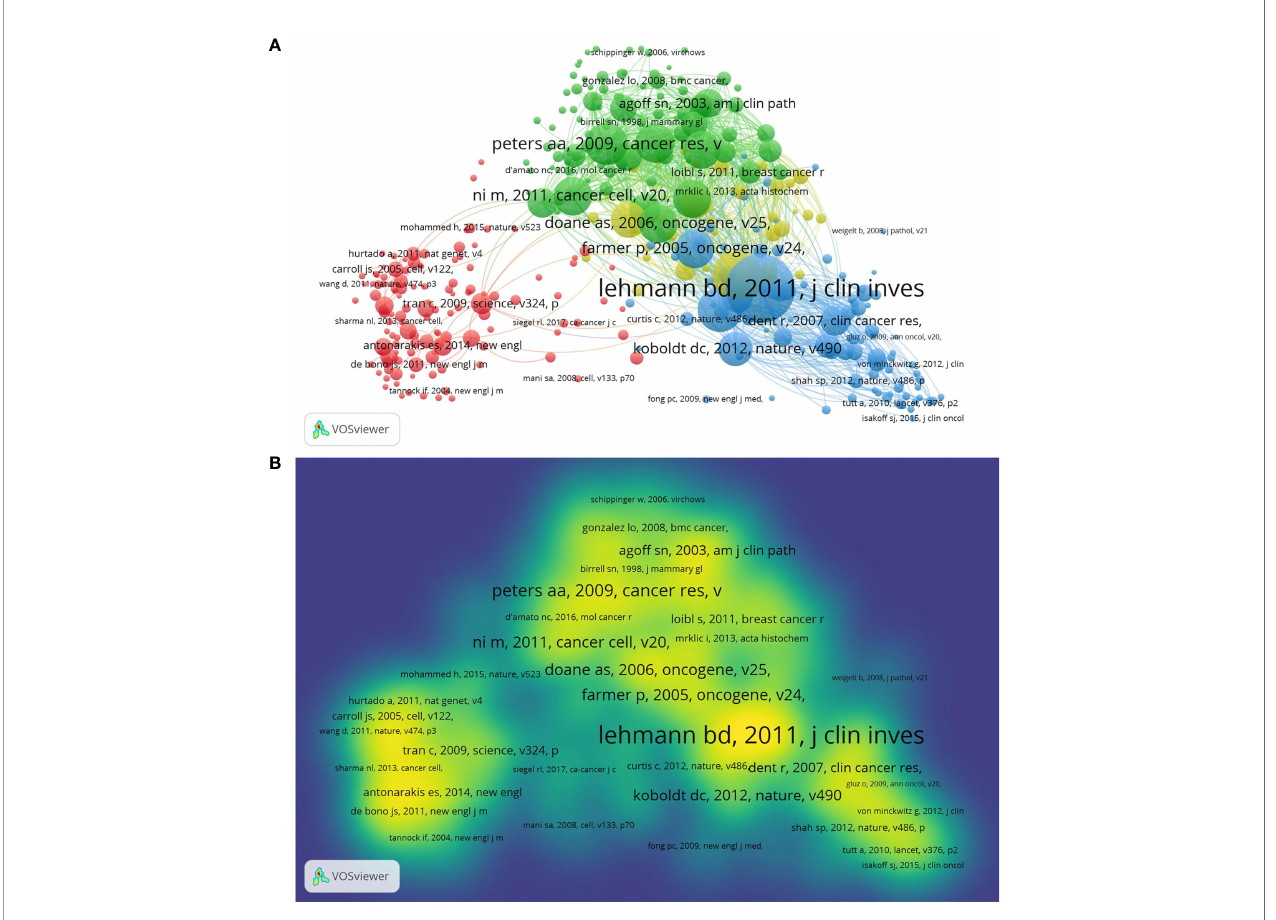
FIGURE 3 | Co-cited network mapping of cited references of these documents. (A) Network map of co-citation between references with more than 20 citations. (B) Density map of co-citation between references with more than 20 citations.